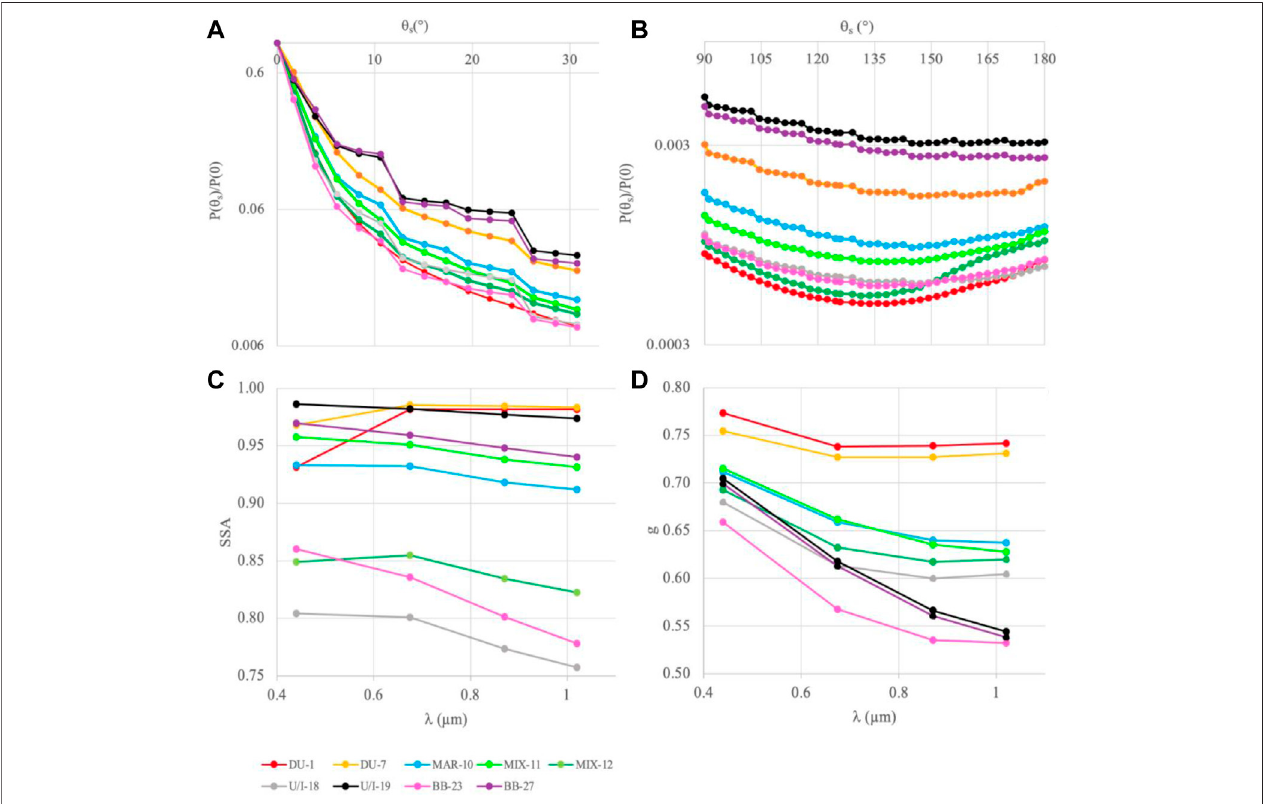
FIGURE 5 | Spectral variation of aerosol properties for selected PAM-derived clusters and associated types. Arithmetic average of normalized phase function at scattering angle θ s = 0 ° ) for forward panel (A) and backscattering angles [panel (B) ], SSA [panel (C) , and g [panel (D) ]. Curves with the same color symbol represent different aerosol models of the same type ( Table 5 ). The numbers next to aerosol types represent PAM-derived subtypes ( Table 5